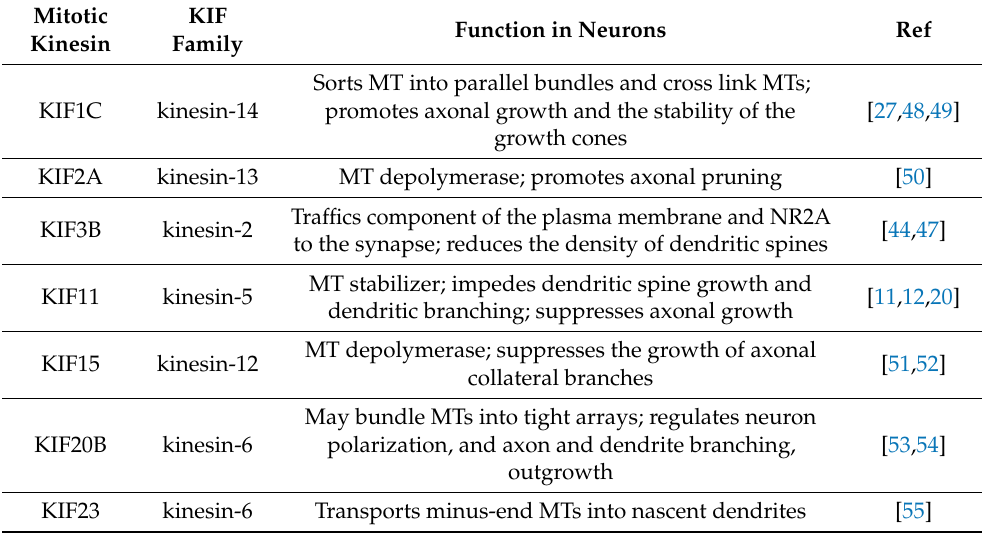
Table 1. Mitotic kinesins and their known functions in post-mitotic